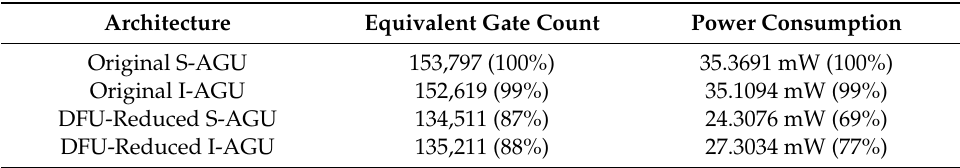
Table 4. Implementation